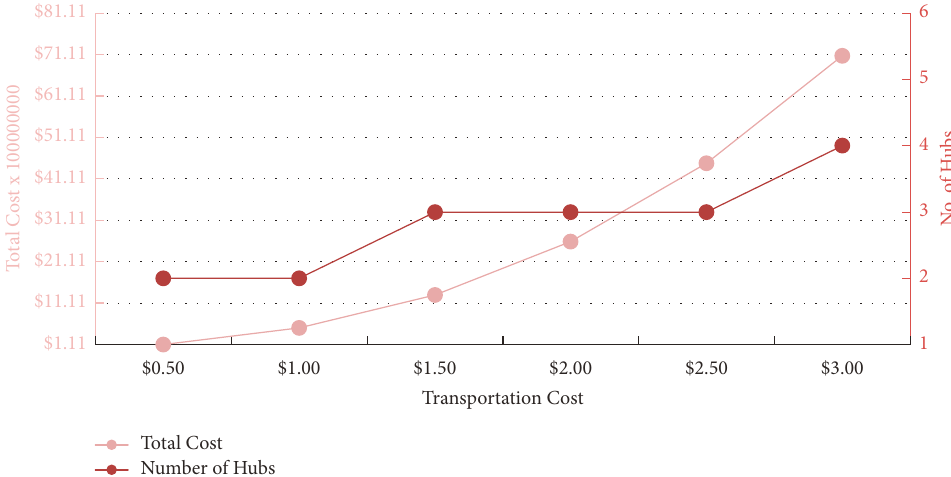
Figure 7: Impact of transportation price, total cost, and no. of hubs.